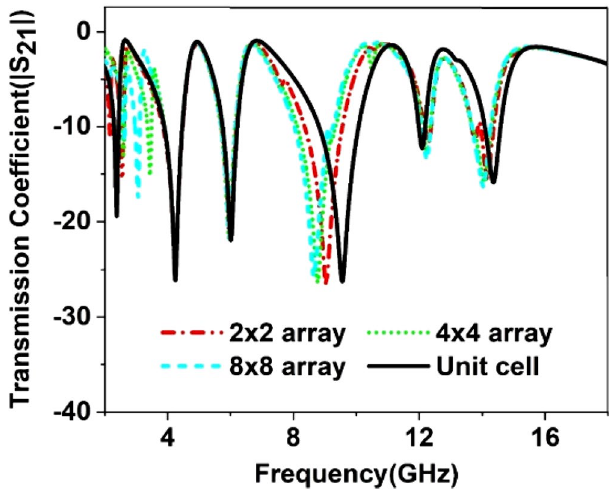
Figure 26. |S 21 | in dB for different arrays and unit cell.